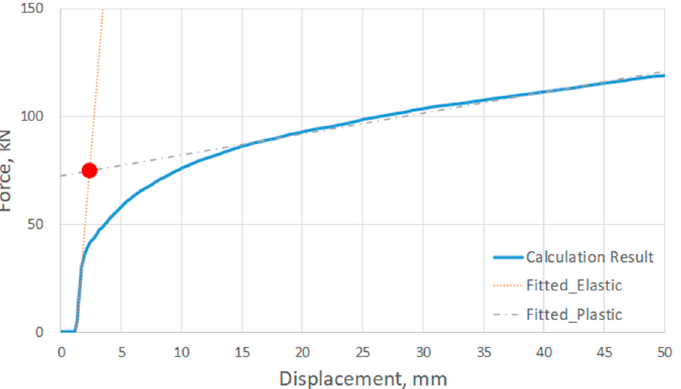
Figure 6. Tangent intersection method for determining the ultimate strength. The red dot indicates the ultimate the ultimate strength.